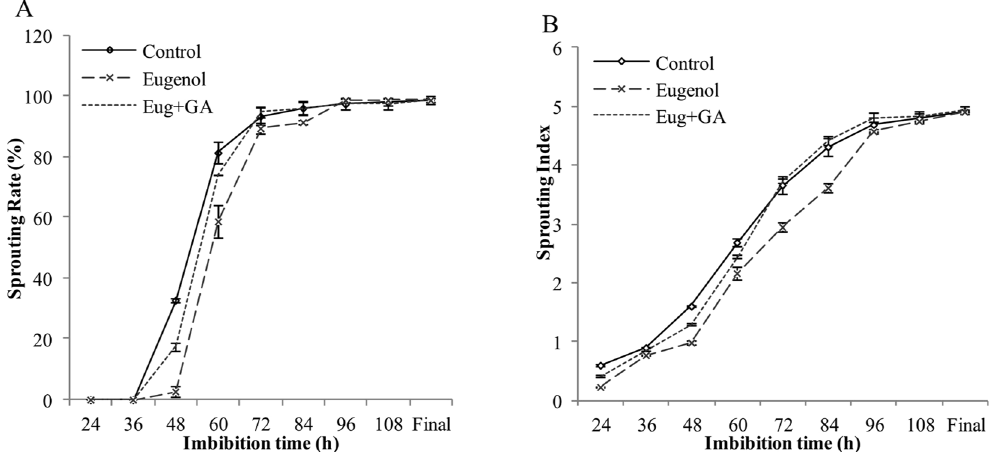
Figure 4. Effects of eugenol alone and eugenol + GA 3 combined treatment on the sprouting rate ( A ) and sprouting index ( B ) of Qian You 1. Control: seeds soaked in water; Eugenol: seeds soaked in 2.0 g · L − 1 of eugenol; Eug + GA: seeds soaked in 2.0 g · L − 1 eugenol + 50 mg · L − 1 of GA 3 mixed solution. The data were the means of three replications, and the standard deviation was indicated by bars.